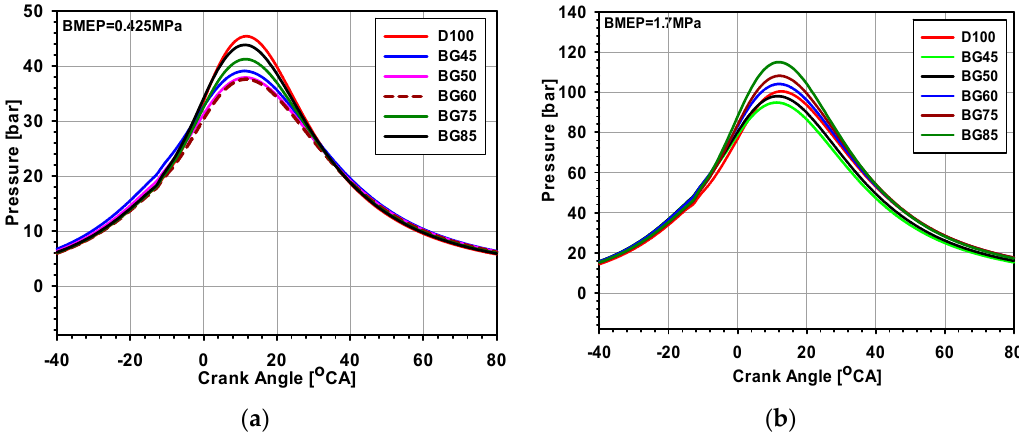
Figure 8. Variations of in-cylinder pressure with crank angle for diesel and biogas-diesel fuels. ( a ) brake mean e ff ective pressure (BMEP) = 0.45MPa, ( b ) BMEP = 1.7MPa.